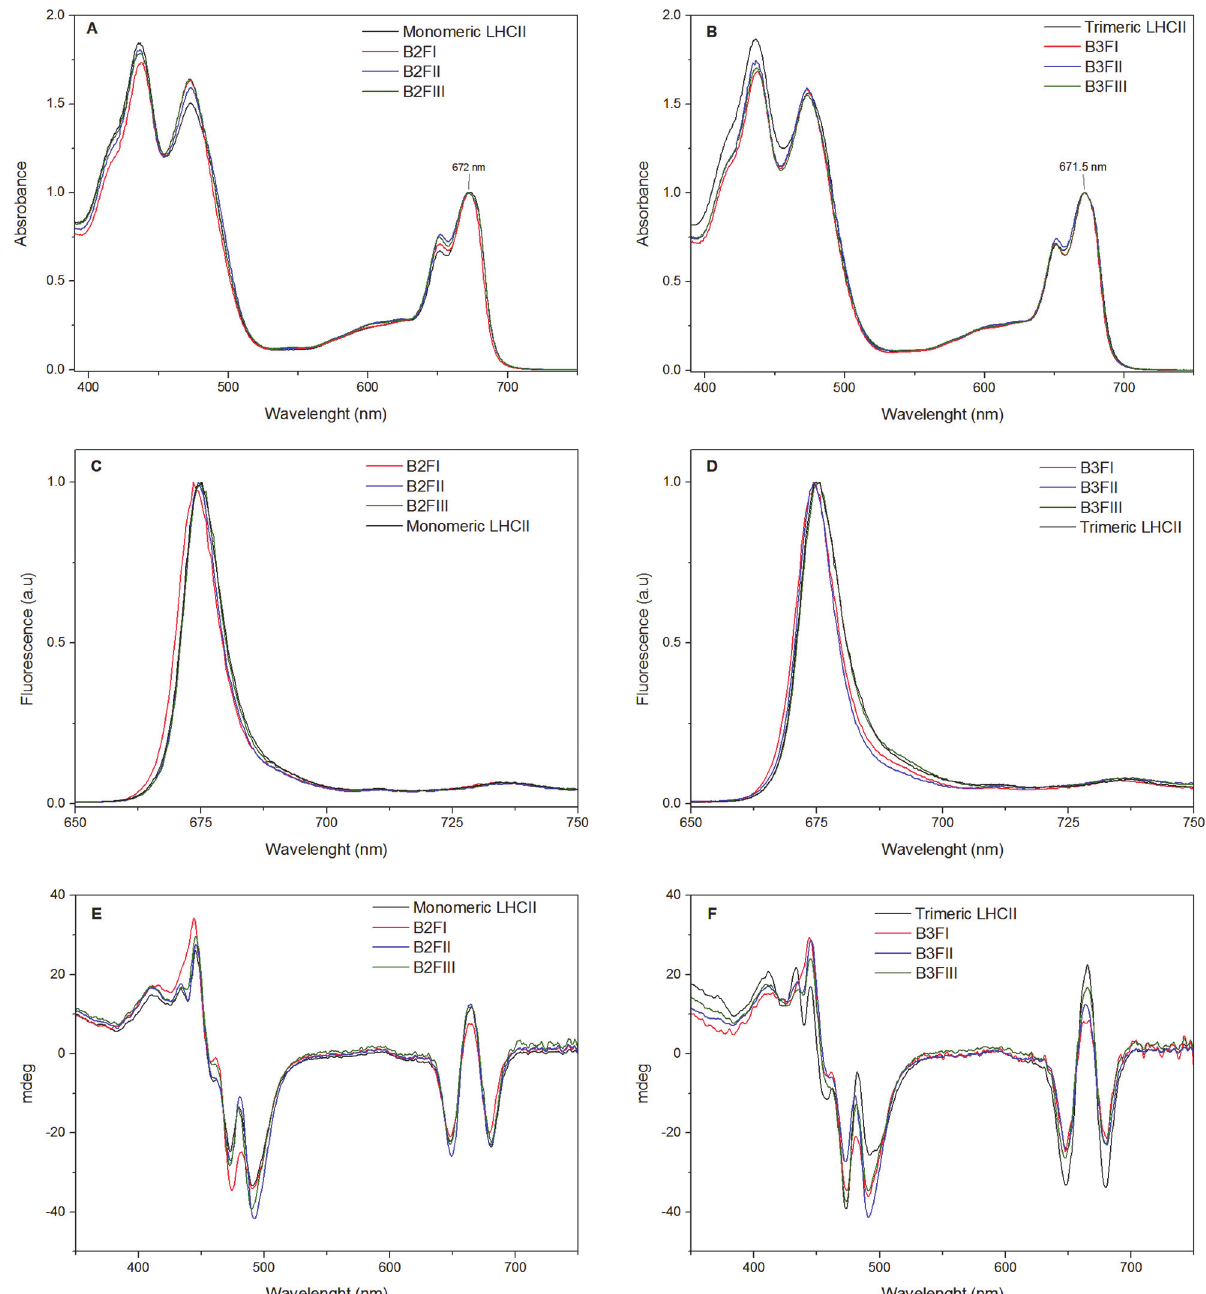
Fig 3. Spectroscopic analysis of the ndIEF fractions. (A) and (B): Absorption spectra of ndIEF fractions. (C) and (D): Fluorescence emission spectra at 77K (excitation at 440 nm). (E) and (F): Circular dichroism spectra at 10°C. B2FI, B2FII, B2FIII: Different fractions from the LHCII monomer. B3FI, B3FII, B3III: Different fractions from the LHCII trimers.